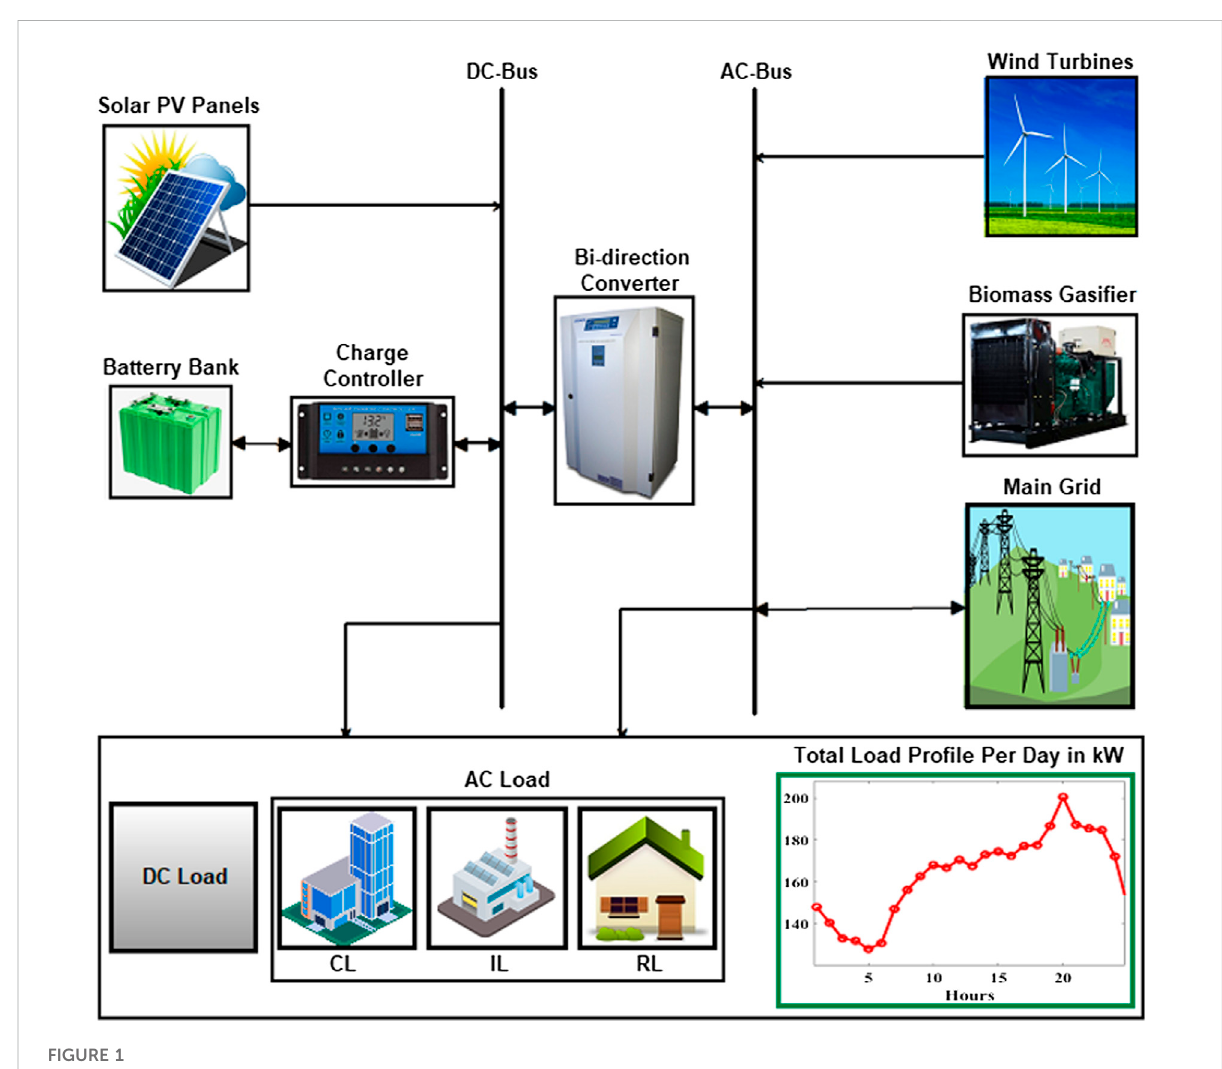
FIGURE 1 The proposed grid connected